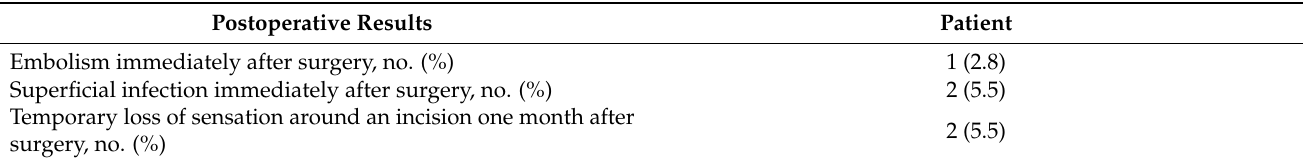
Table 5. Postoperative results and one-month re-examination ( N =